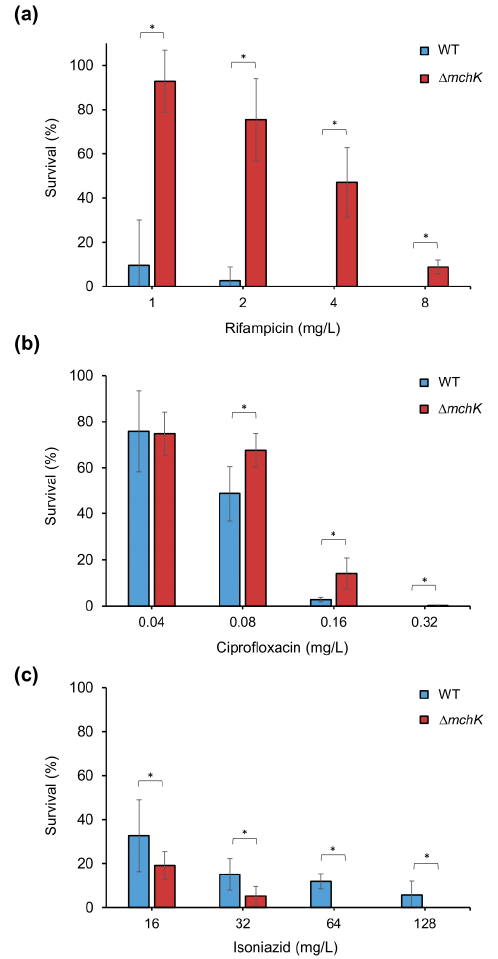
Figure 2. Survival (%) of M. smegmatis mc 2 155 wild-type (blue bars) and the ∆ mchK mutant (red bars) under different antibiotic concentrations. Percentages of survivors of the wild-type and the ∆ mchK mutant to rifampicin ( a ), ciprofloxacin ( b ) and isoniazid ( c ) at the indicated antibiotic concentrations are shown. Error bars indicate 95% CI (confidence intervals); (*) p < 0.05 ( t -test).